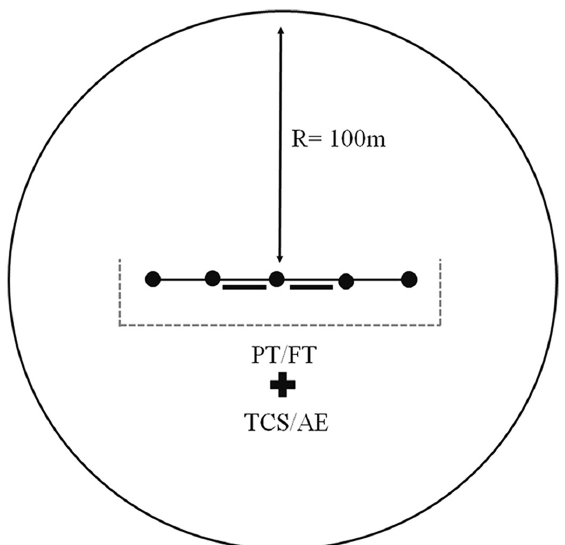
Figure 2. Diagram showing the spatial conformation of our sample